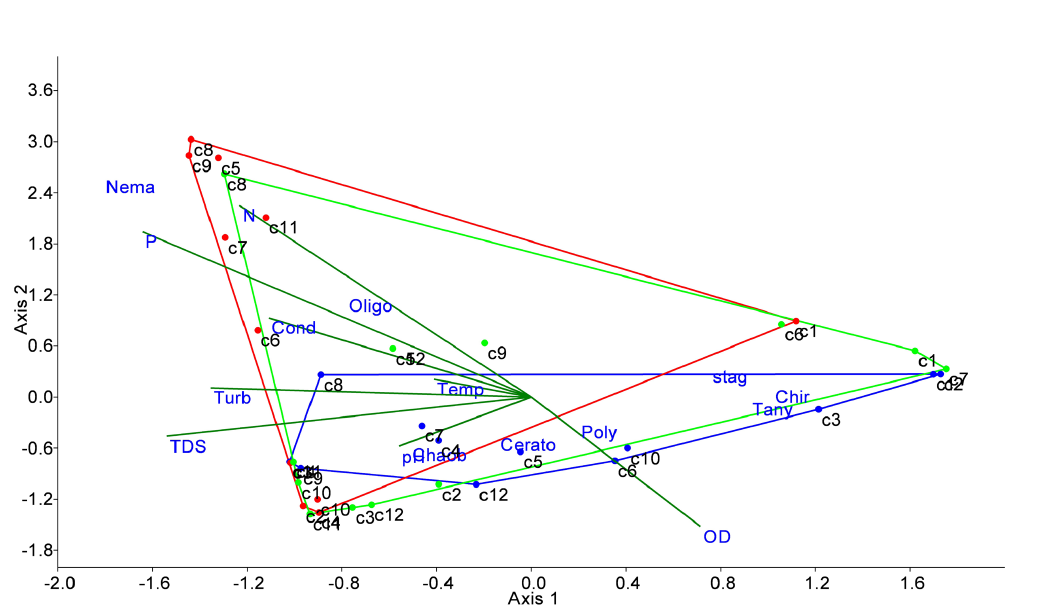
Figure 6. Results of canonical correspondence analysis (CCA) to verify the ordering of the sampling sites in relation to the intensity of the association among the abiotic and biotic variables. The numbers represent the collections (samples): C1 (17.04.12), C2 (22.05.12), C3 (26.06.12), C4 (26.06.12), C5 (13.09.12), C6 (24.09.12), C7 (06.11.12), C8 (04.12.12), C9 (18.12.12), C10 (17.01.13), C11 (05.03.13) and C12 (26.03.13). The lines (convex hull) indicate the cloud (data points) represented by the measurements at each site: P1 - Taquacetuba (blue), P2 - Alvarenga (red) and P3 - Biguás Island (green) in Billings Reservoir (Brazil, São Paulo State). The vectors (dark green) show the contributions of the variables pH, temperature (Temp), electrical conductivity (Cond), turbidity (Turbz), total dissolved solids (TDS), total nitrogen (N), total phosphorus (P) and dissolved oxygen (DO), and the Chironomini (Chir), Tanypodinae (Tany), Chaoborus (Chao), Ceratopogonidae (Cerato), Polymitarcyidae (Poly), Nematoda (Nema), Helobdella stagnalis (stag) and Oligochaeta (Oligo) in the formation of the